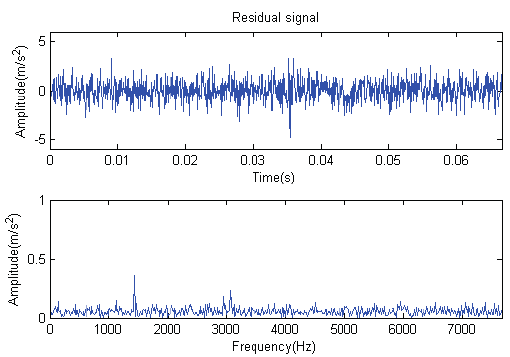
Figure 15. Residual signal.